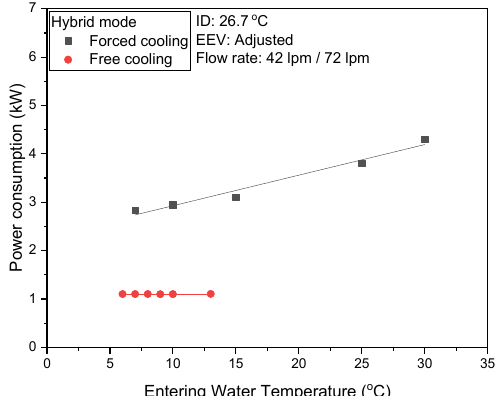
Figure 17. Saturation temperatures according to EWT in hybrid mode.